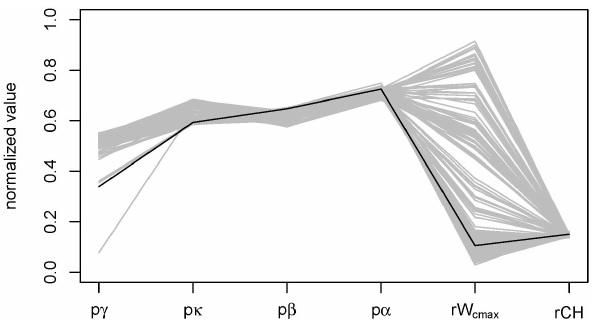
Figure 5. The normalized factor sets associated with MOO (grey lines) and the solution with SOO (dark